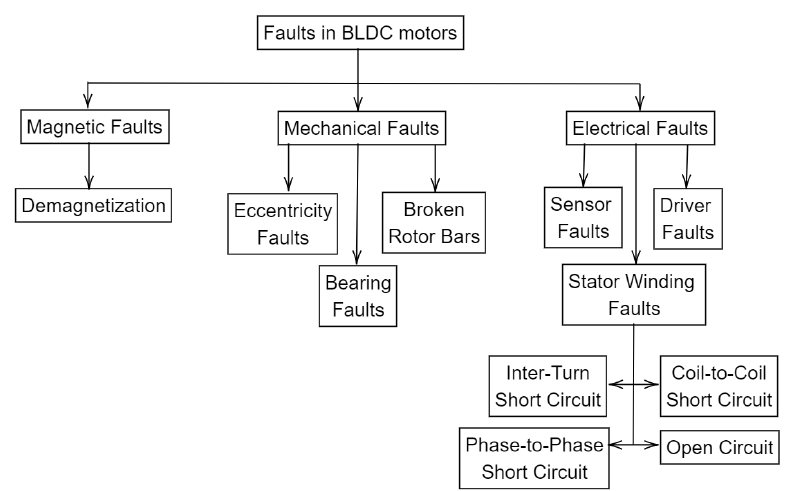
Figure 3. Classification of faults in a BLDC motor.